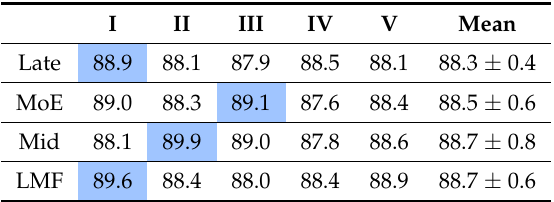
Table 2. The comparison of four fusion methods performed on the BioTac Grasp Stability Dataset (BiGS)